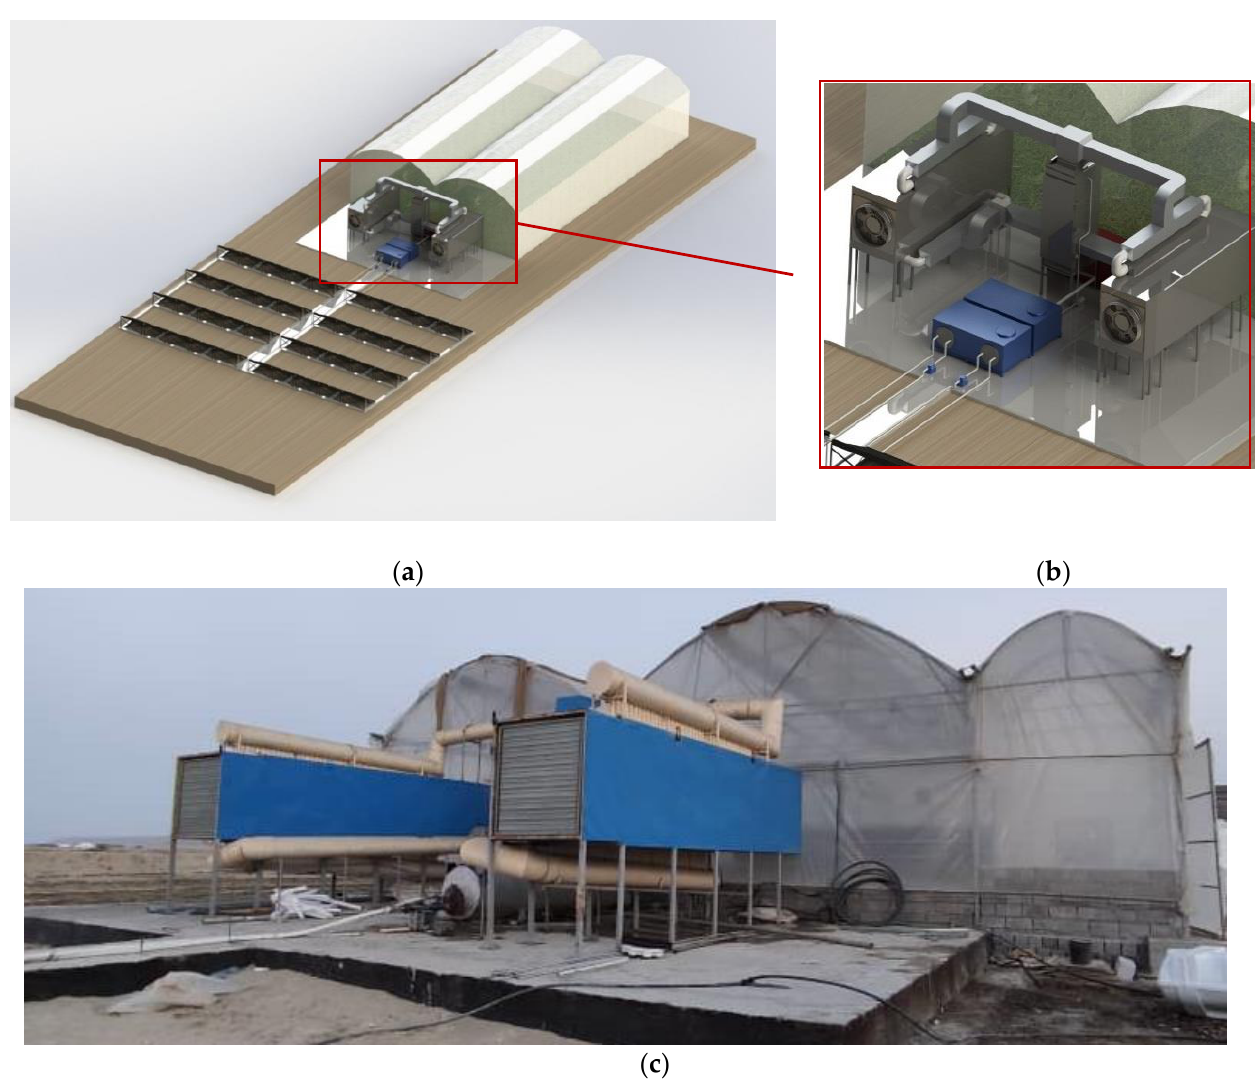
Figure 7. ( a ) Schematic of the seawater greenhouse equipped with HD desalination unit, ( b ) schematic of HD desalination unit and ( c ) the photo of installed unit in MAKRAN coast, Iran.